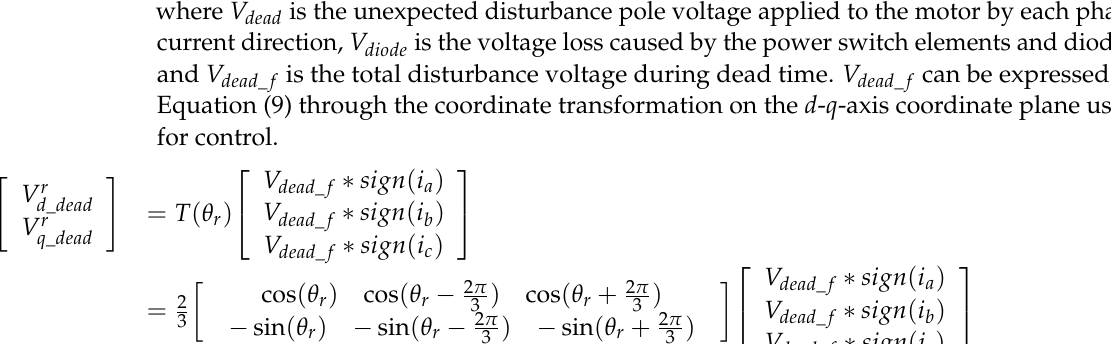
The disturbance voltage values, V r and V r , generated during the dead time d _ dead q _ dead and obtained through Equation (9) are shown in Figure 9 on the d - q -axis coordinate plane through MATLAB R2022a simulation. In addition, the disturbance voltage applied to each phase of the motor at the dead time is expressed in Figure 10b. The ideal gate voltage and the gate voltage considering the dead time and the pole voltage output from VSI to the motor, when the sign of the current output to the phase is negative and positive are shown in Figure 10a. The disturbance voltage causes the distortion of the current waveform applied to the actual three phases of the stator. This can be confirmed in Figure 11. In the case of the DTC algorithm, as was mentioned in the previous section, the stator flux is estimated using the measured three-phase currents. Therefore, the distortion of the three- phase current also appears in the trajectory of the stator flux estimated in the DTC − SVM algorithm. In addition, it can be predicted that the distortion of the estimated stator flux trajectory eventually causes torque ripple during the DTC − SVM algorithm. This was demonstrated through simulations and